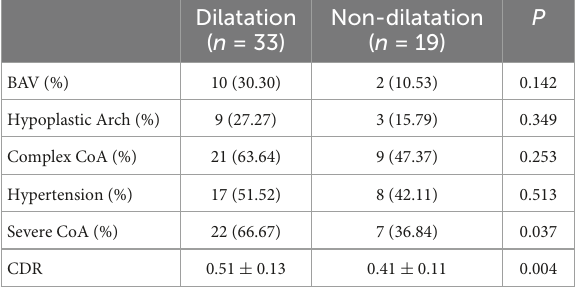
TABLE 3 Analysis of factors affecting dilatation of ascending aorta.